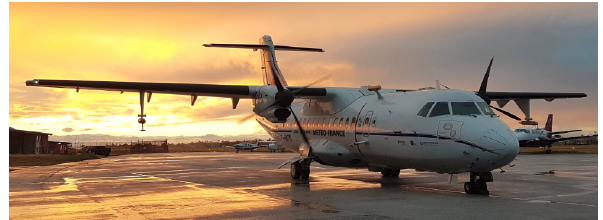
Figure 1. The ATR coming back from its successful EMI flight in Barbados on 23 January 2020.